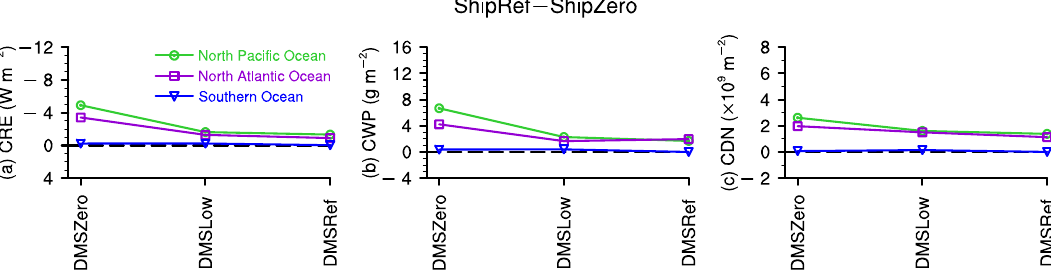
Figure 12. Same as Fig. 8, but using a different aerosol module, namely MAM3 rather than